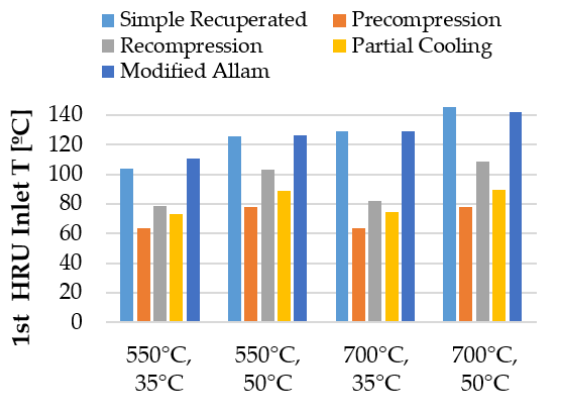
Figure 7. Inlet temperature to the first heat rejection unit of the sCO 2 configurations studied, for different boundary conditions.